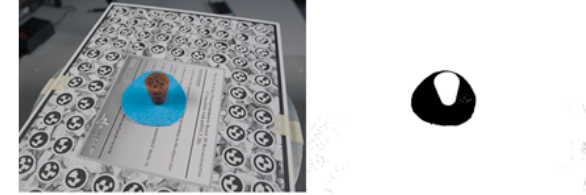
Figure 6. Masking steps of object images for successful alignment from different sides